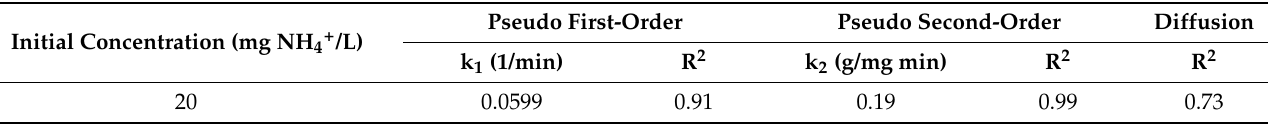
Table 4. Pseudo first-order, pseudo second-order, and diffusion kinetic models.